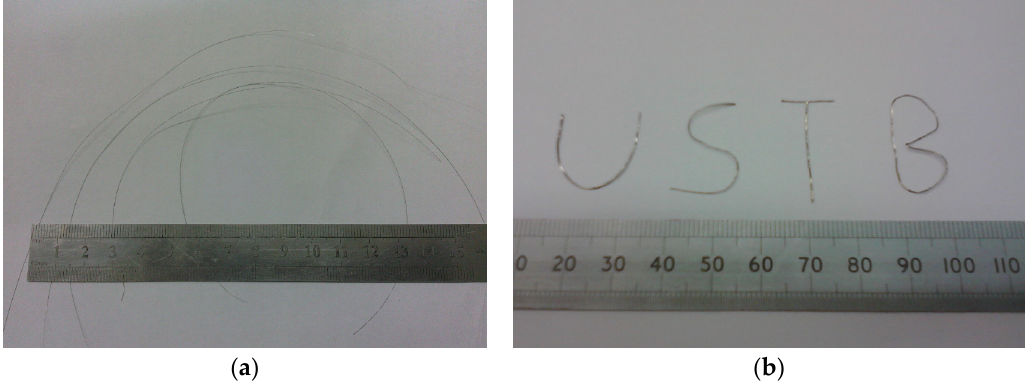
Figure 2. Pictures of the glass-coated fibers with composition of Ni53–Mn26–Ga21 ( a ) and deformed in to the letters U, S, T, and B with the fibers Ni55–Mn24–Ga21 ( b ).